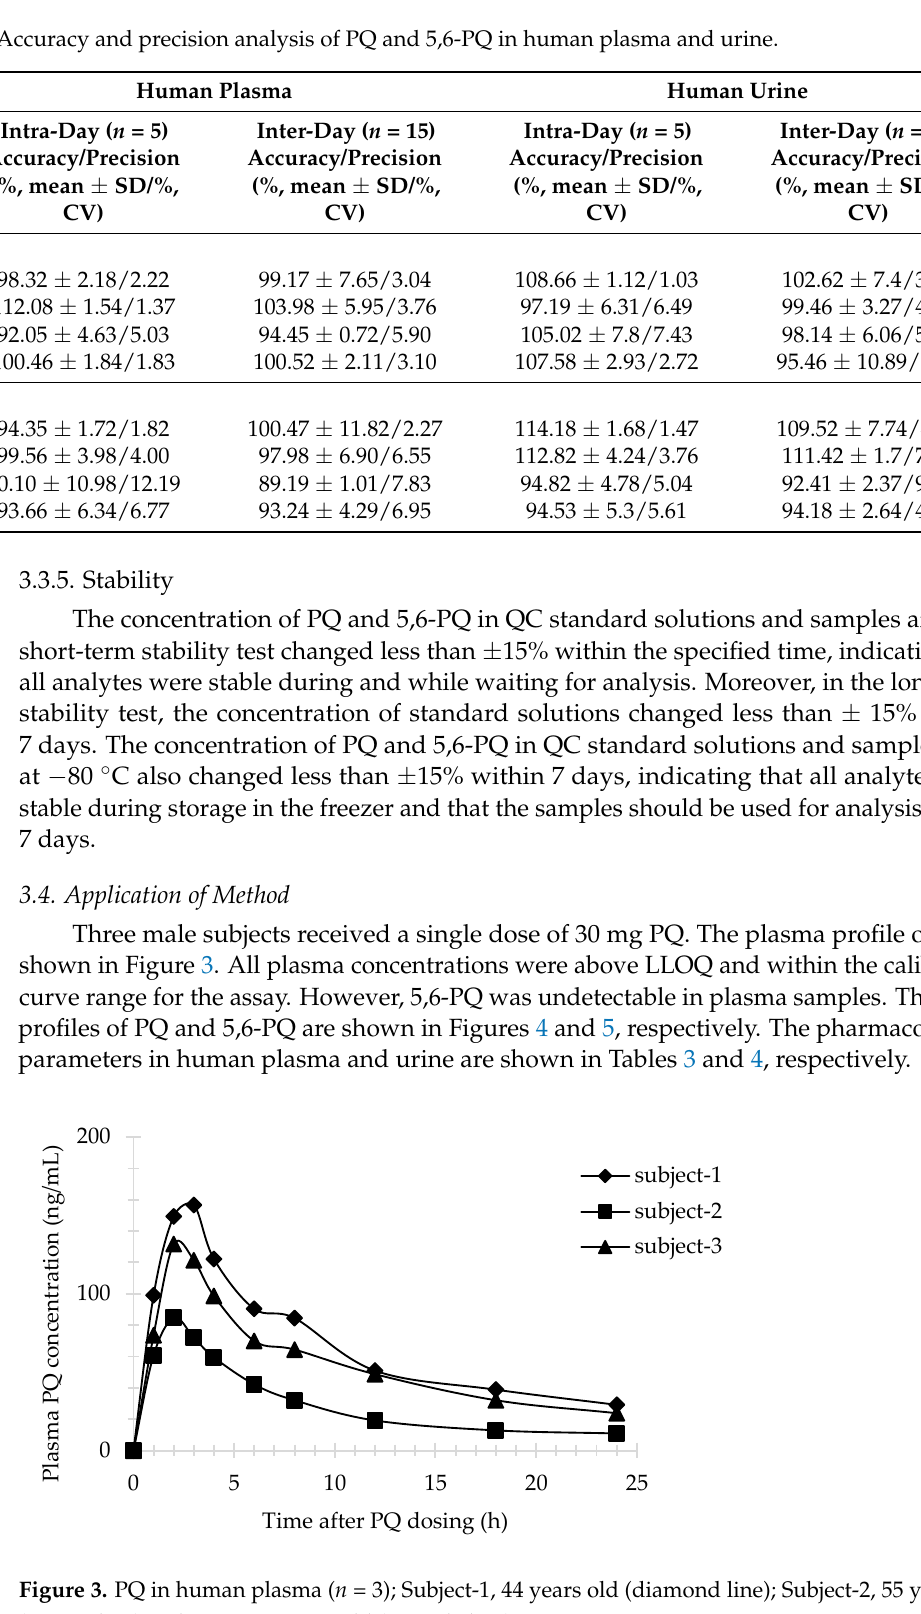
Figure 3. PQ in human plasma ( n = 3); Subject-1, 44 years old (diamond line); Subject-2, 55 years old (square line); Subject-3, 49 years old (triangle line).